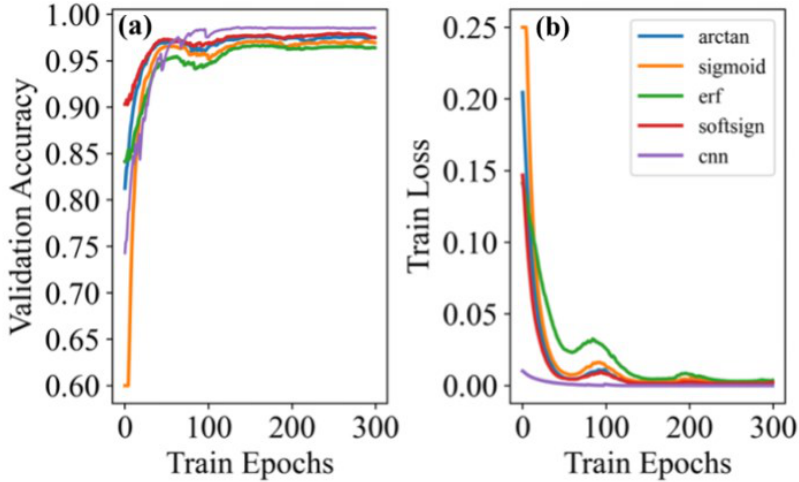
Figure 7. The validation accuracy ( a ) and training loss ( b ) for different gradient surrogate functions. Next, the effect of observation time T on the validation performance is also considered.